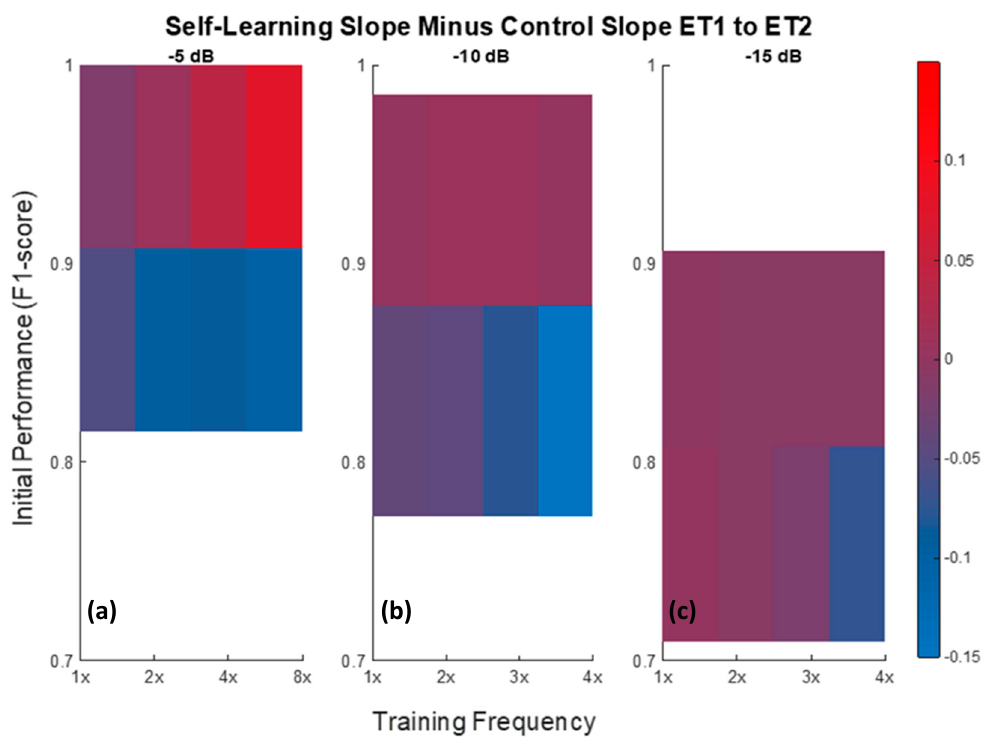
Figure 11. Self-learning slope minus control slope between ET1 and ET2 for SNRs of − 5, − 10, and − 15 dB. The − 5 dB plot ( a ) shows two levels of initial performance (F 1 -score = 0.9997 and 0.8153). The − 10 dB plot ( b ) shows two levels of initial performance (F 1 -score = 0.9852 and 0.7720). The − 15 dB plot ( c ) shows two levels of initial performance (F 1 -score = 0.9065 and 0.7096).